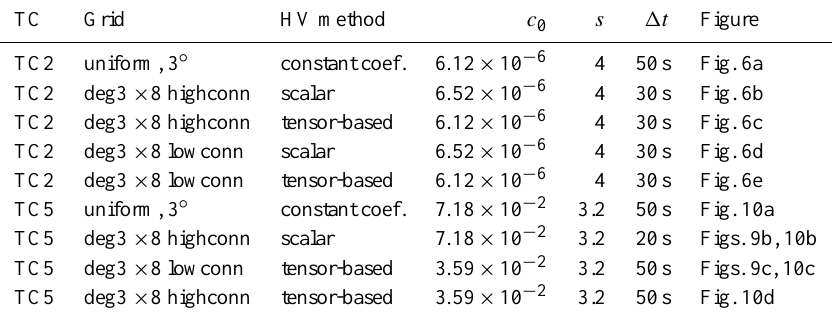
Table 2. Summary for simulations. TC stands for a test case, and the numbers in c 0 and s are parameters in the hyperviscosity coefficient ν = c 0 ((cid:49)x) s